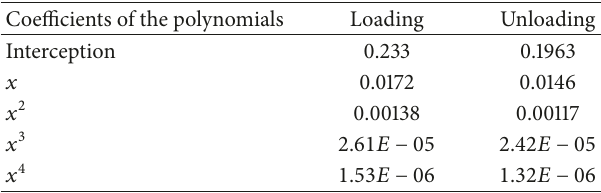
Table 3: Standard error of the polynomials for load and deflection curves of journal